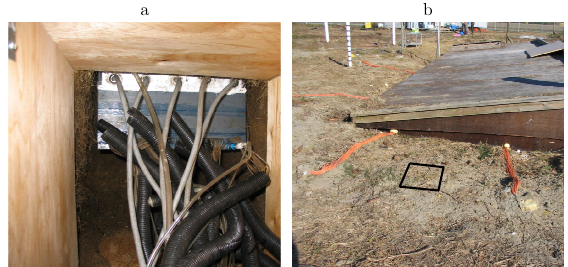
Fig. 1. Experimental setup. Installation of the multi-compartment